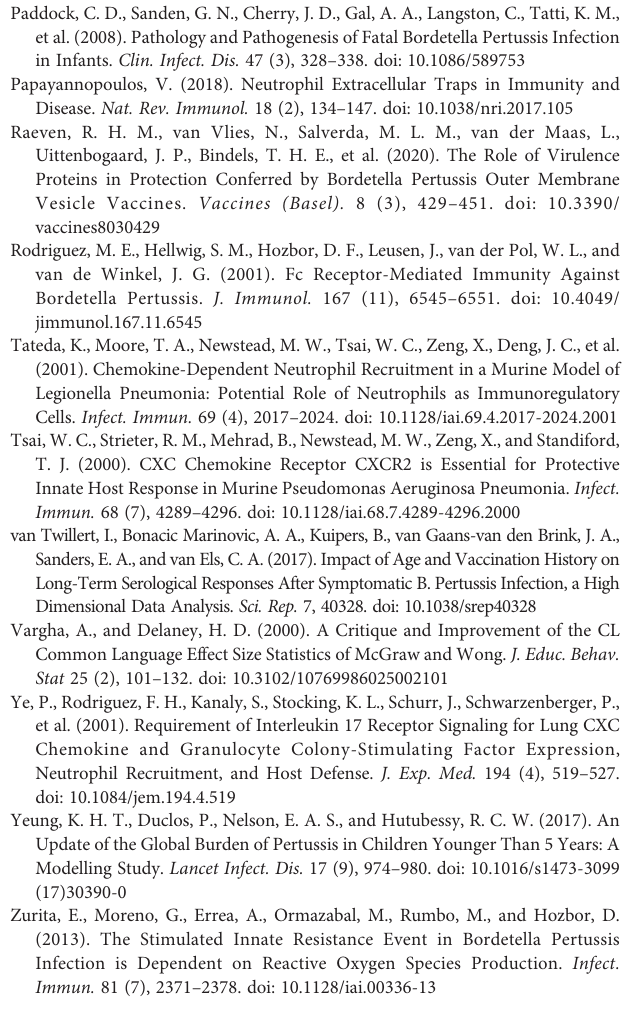
(MOI 10), B. pertussis opsonized with a reference serum from a pertussis patient and/or the VAS3947 NOX inhibitor VIII. Data are represented as mean ±